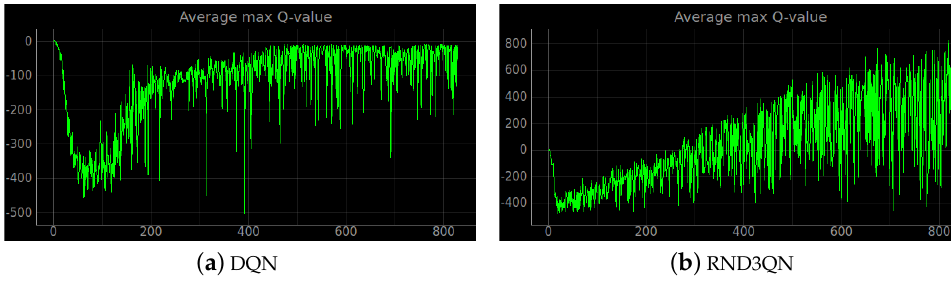
Figure 14. The average of the value functions for each episode in the stage 4. ( a ) Is the average curve of the maximum Q-values of the original DQN algorithm. ( b ) Is the average curve of the maximum Q-values of the RND3QN algorithm. The goal of reinforcement learning is to continuously improve the value of the value function. It can be seen from the figure that the maximum Q-values of the original DQN are all less than 0. The agent has not learned an effective policy. While the maximum Q-value of the RND3QN algorithm steadily